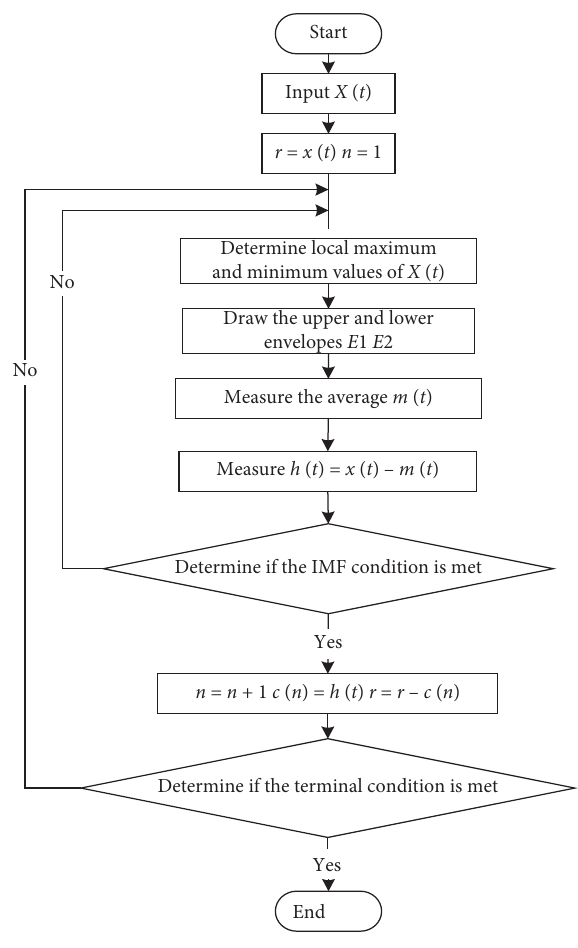
Figure 1: The structure of